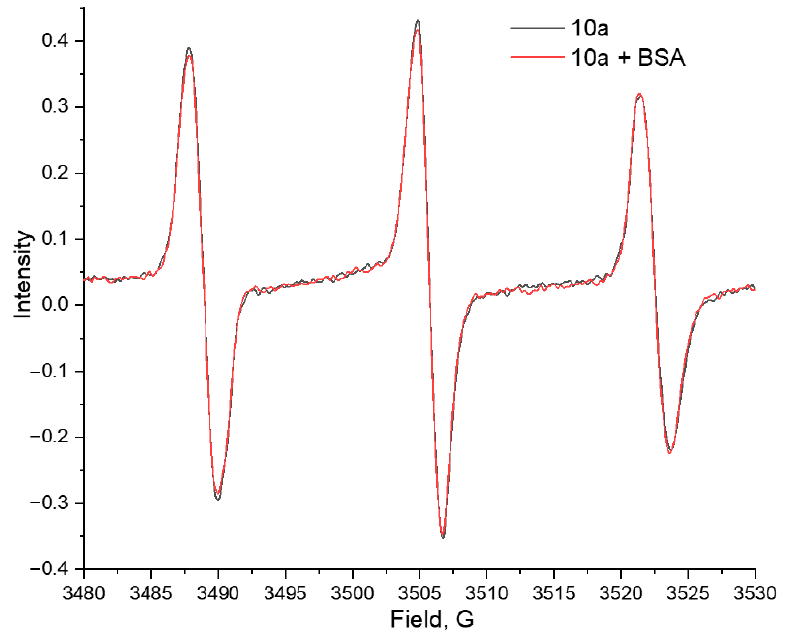
Figure 16 . EPR spectra of aqueous solutions of compound 10a and its mixture with BSA at r.t. Figure 16. EPR spectra of aqueous solutions of compound 10a and its mixture with BSA at